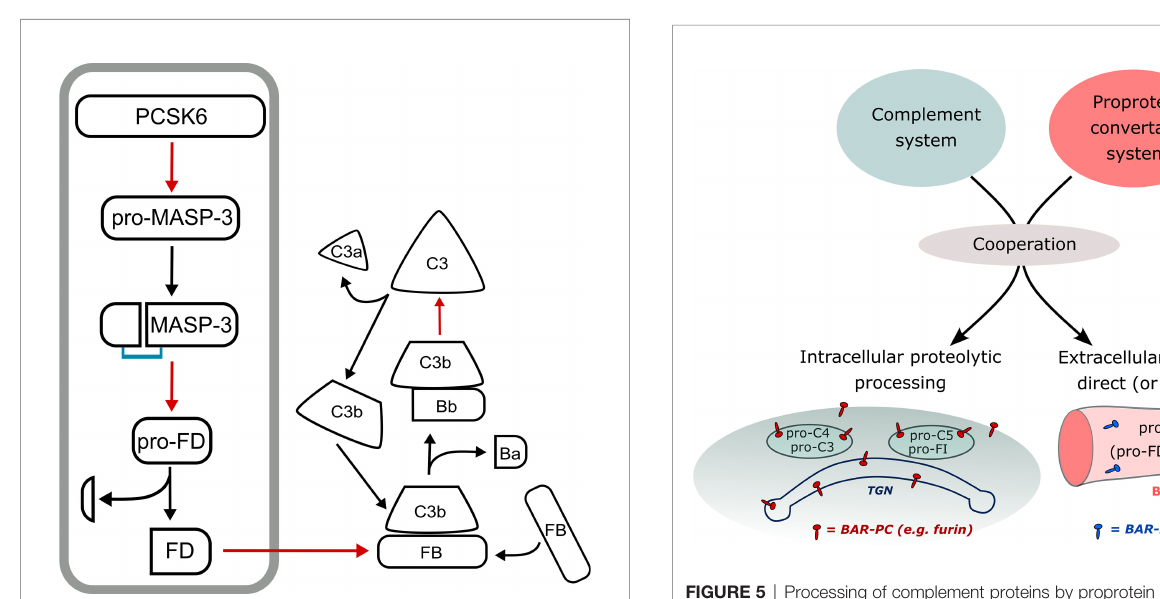
FIGURE 5 | Processing of complement proteins by proprotein convertases in different compartments of the body. Cooperation between the complement system and BAR-PCs (basic amino acid residue-speci fi c proprotein convertases) results in proteolytic processing of complement proteins inside the cell or extracellularly in the blood. BAR-PCs such as furin localize to the membrane of the trans-Golgi network (TGN), secretory vesicles and endosomes. Processing of pro-C3, pro-C4, pro-C5, and pro-factor I probably occurs in these compartments. The direct activation of pro-MASP-3 occurs in the blood by circulating PCSK6 (PACE4). Pro-factor D is the substrate of active MASP-3 therefore it is an example of indirect activation by